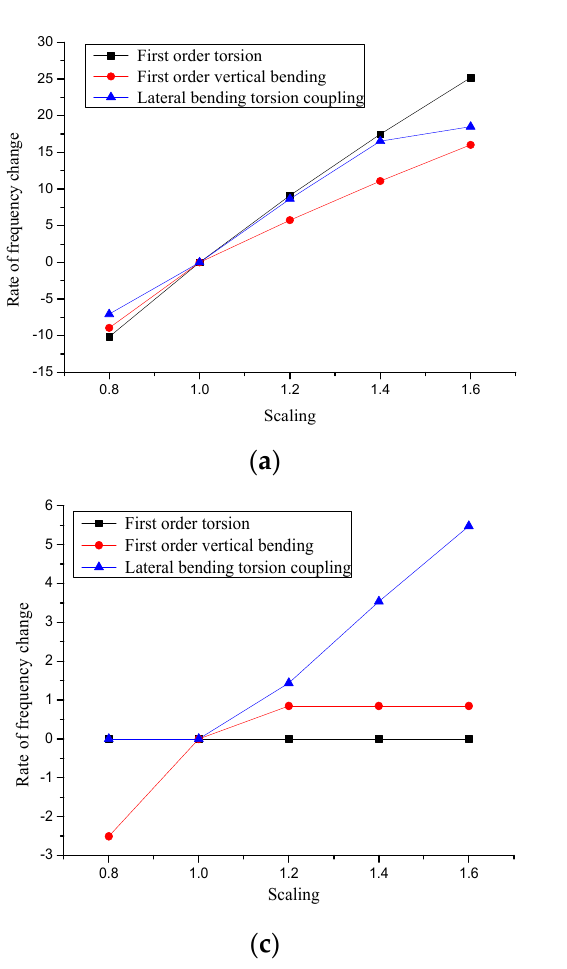
Figure 7. Influences of the key components’ stiffness on vibration frequencies of typical vibration modes: ( a ) The influences of main girder rigidity; ( b ) the influences of bridge tower; ( c ) the influences of stayed cable stiffness.